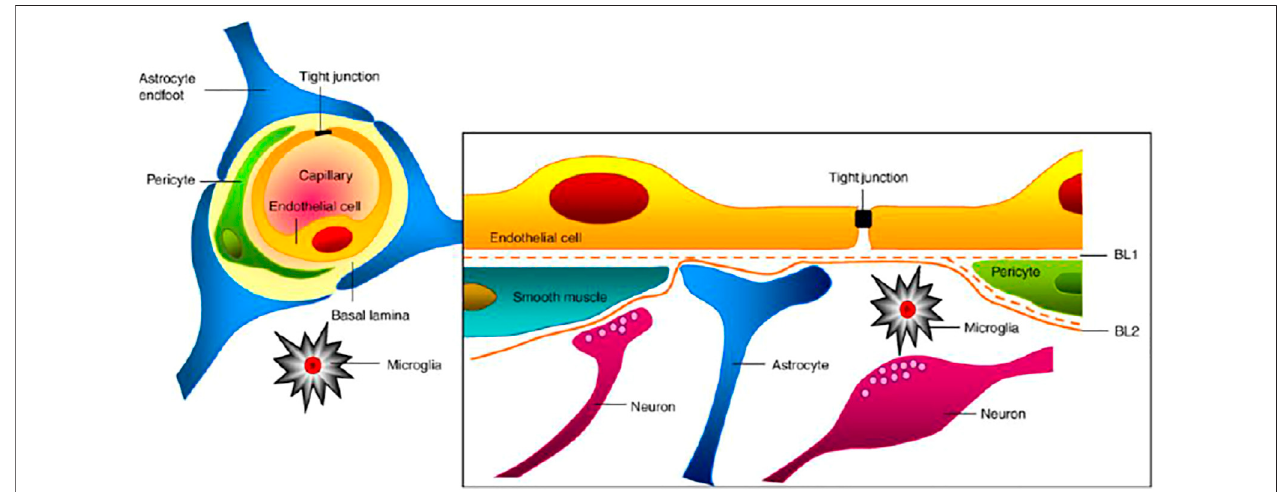
FIGURE 1 | Association of different cells at the blood – brain barrier (Abbott et al.,